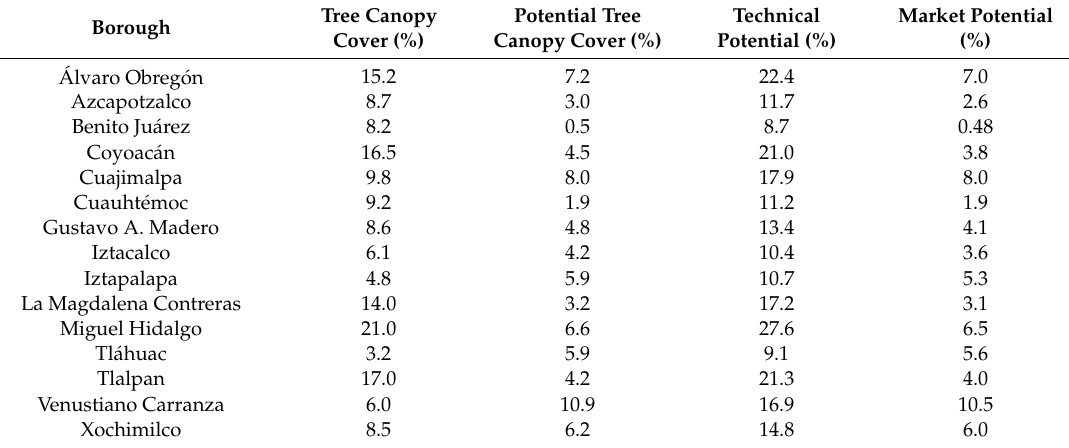
Table 6. Percentages of canopy cover in Mexico